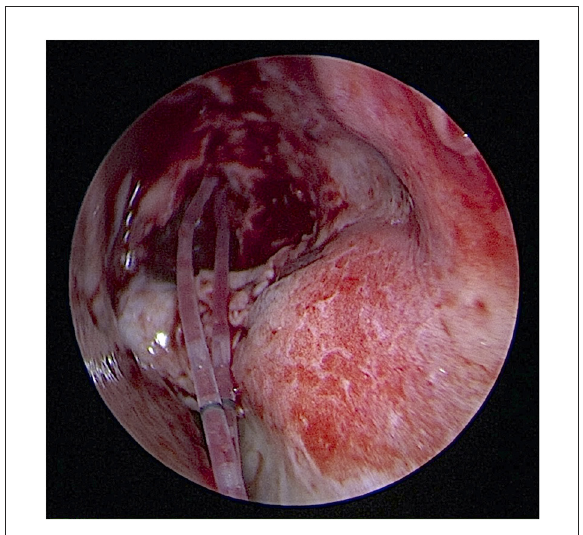
FIGURE2 The pushed-type bicanalicular silicone stent (Nunchaku ® ) was pushed through the lower and upper pucta into the nasal cavity. No knots or suture were needed for fixation.